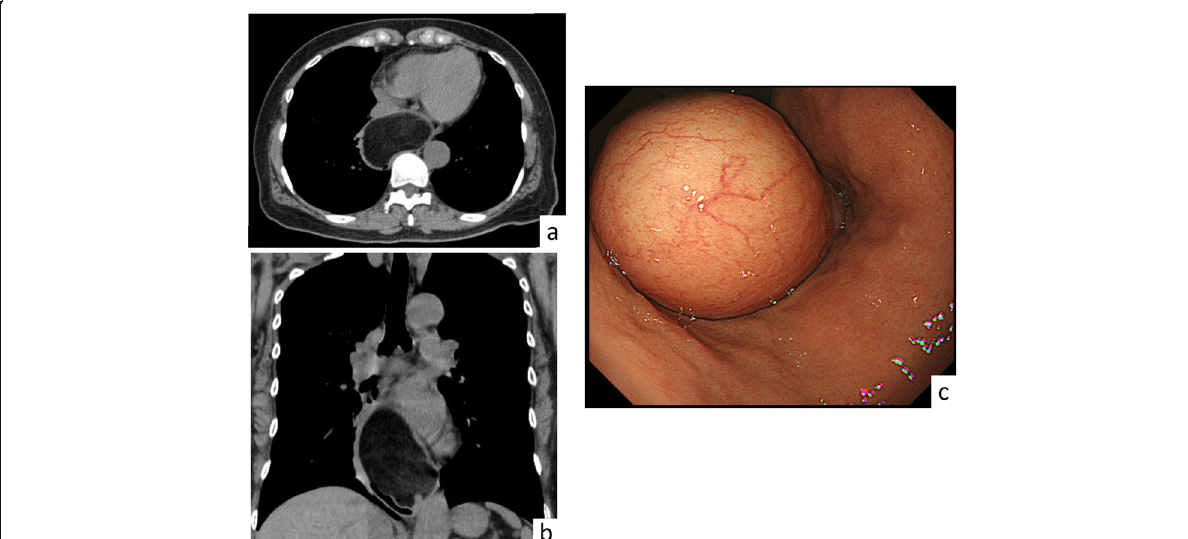
Fig. 1 Preoperative imaging. ( a horizontal, b coronal) CT scan of the chest revealed a 10 × 7 cm homogenous mass in the middle and lower esophagus. c Upper endoscopy revealed a submucosal tumor with normal mucosa arising from the left esophageal